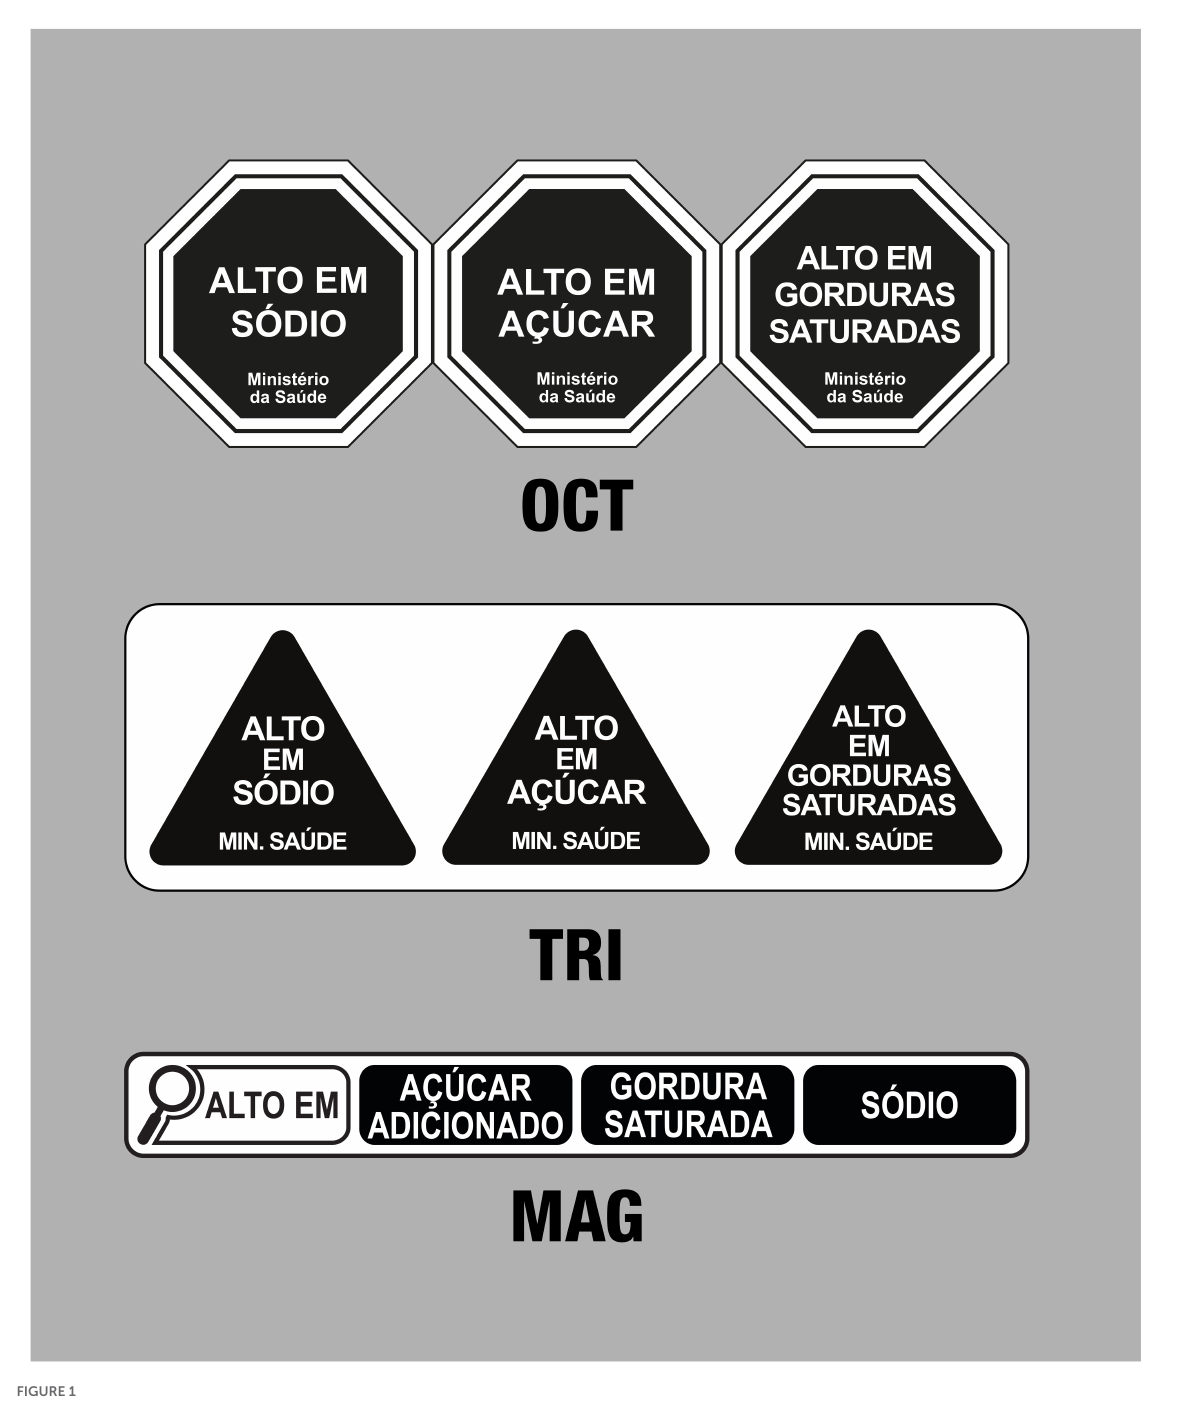
FIGURE1 Models of front-of-package nutritional labeling tested in the study. OCT, octagon; TRI, triangle; MAG, magnifying glass.